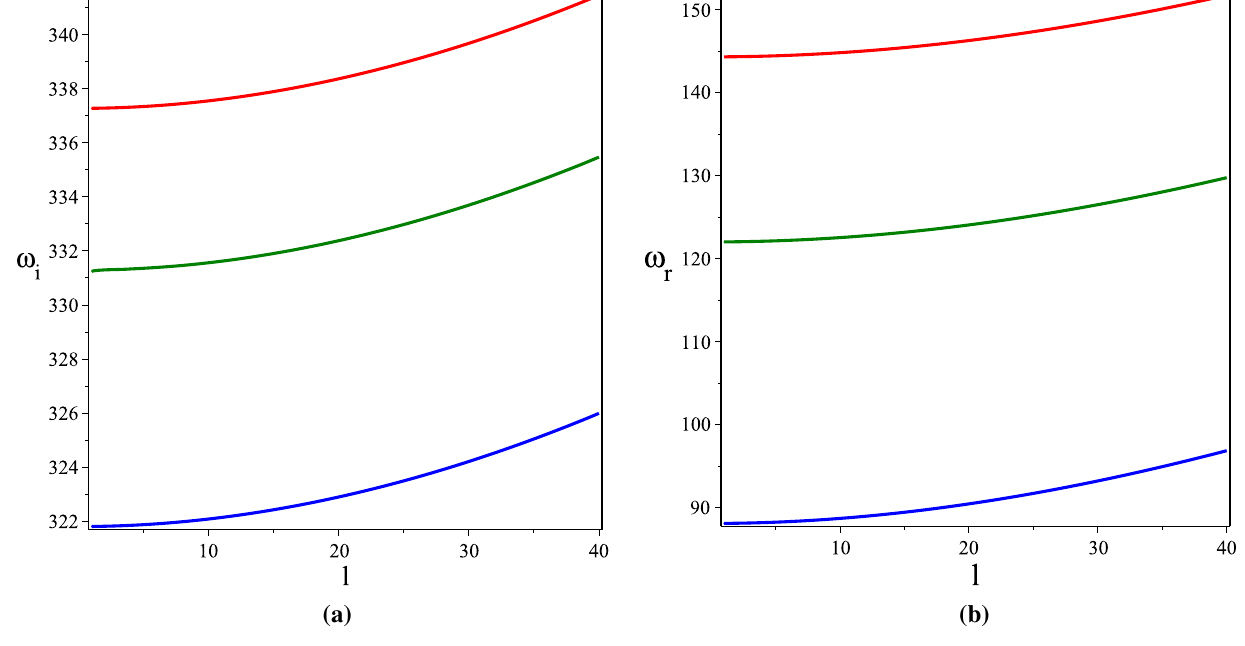
Fig. 12 The behavior of ω i and ω r in terms of l for Q = 5 , 25 , 40 , b = 1 , r + = 100 (downwards)